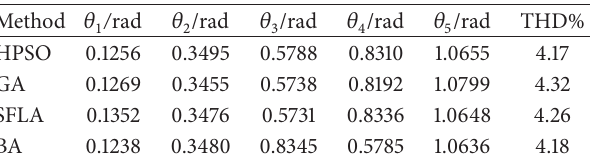
Table 2: Calculated switching angles by different methods at operating point ( 𝑚 ∗ = 1.0 ).